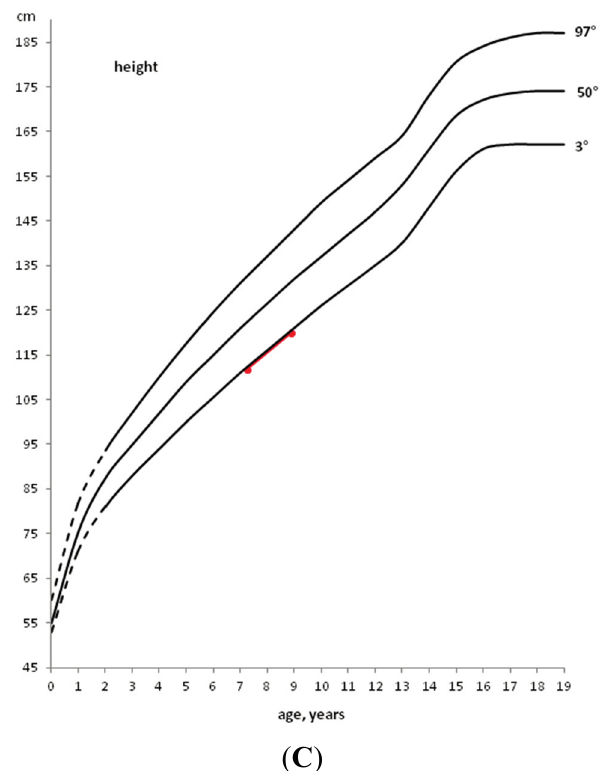
Figure 1. Example of patients with height below the 3rd percentile ( A ), with height, initially above the 50th percentile, that decreases to a lower percentile ( B ) and with height within the 3rd percentile that does not decrease to a lower percentile ( C ).